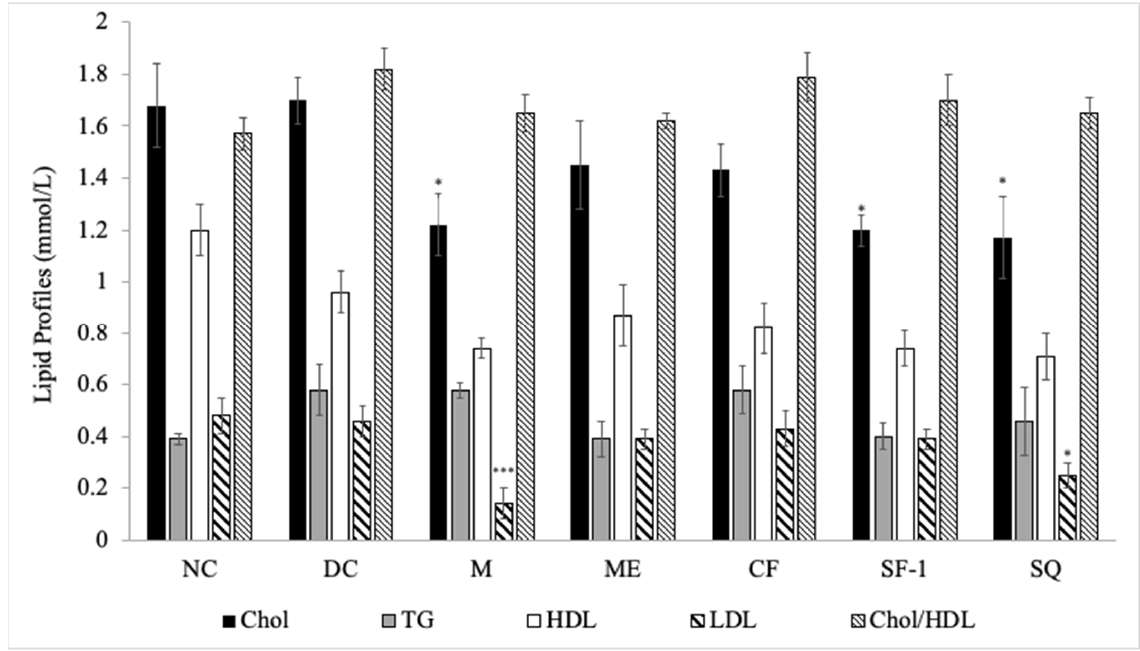
Figure 5. Effects of S. polyanthum on the lipid profiles of streptozotocin-induced diabetic rats after 12-day twice-daily oral treatments. NC, normal control (normal saline, 10 mL/kg); DC, diabetic control (normal saline, 10 mL/kg); M, metformin (500 mg/kg); ME, methanol extract (1 g/kg); CF, chloroform fraction (500 mg/kg); SF-1, subfraction-1 (250 mg/kg); SQ, squalene (160 mg/kg); Chol, cholesterol; TG, triglycerides; HDL, high-density lipoprotein; LDL, low-density lipoprotein. The values are expressed as mean ± SEM ( n = 6); * p < 0.05 and *** p < 0.001 indicate significant differences compared to the DC as analyzed using Dunnett as post hoc test.